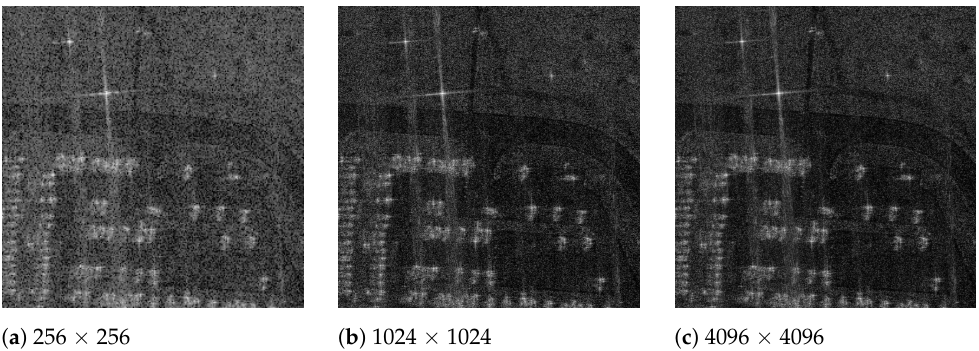
Figure 9. BP-VISAR frames of different frame resolutions (full-aperture processing in overlapped mode, frame 7, α =